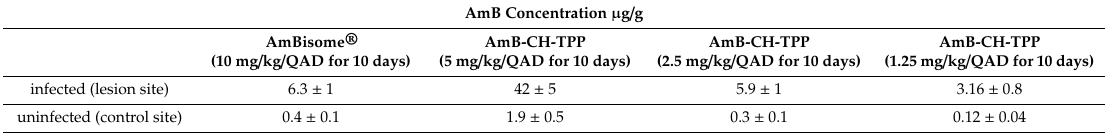
Data are expressed as mean ± SD.